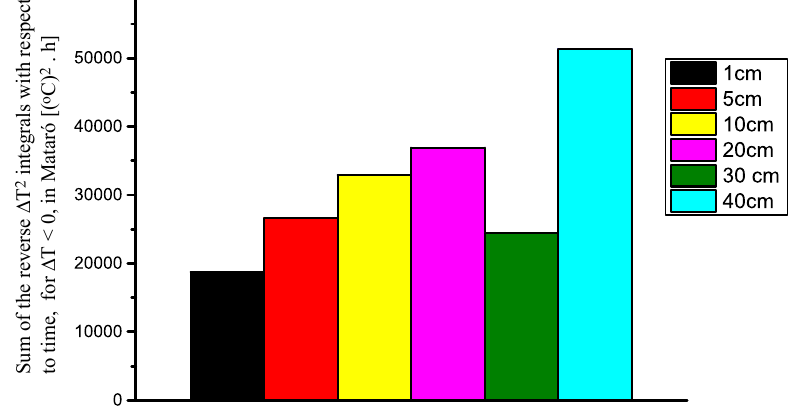
Figure 10. Sum of the “reverse” integrals of ∆ T 2 with respect to time, at various depths, for 205 days, in Mataró.